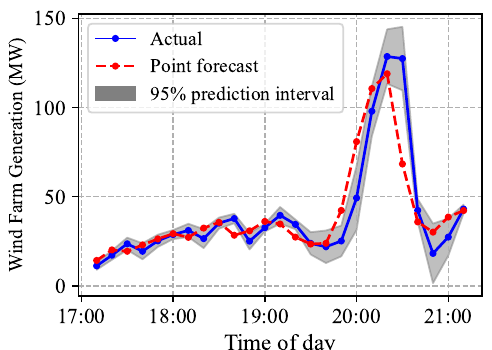
Figure 11. On 19 March 2010.